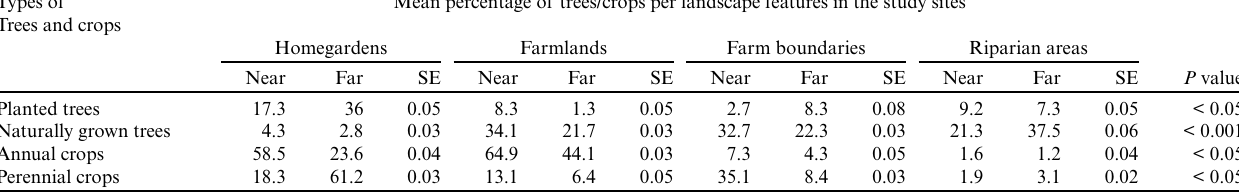
Table 1. Multiple comparisons of woody species and food crop integration near to and far from the forest. P values are from linear mixed effect models.